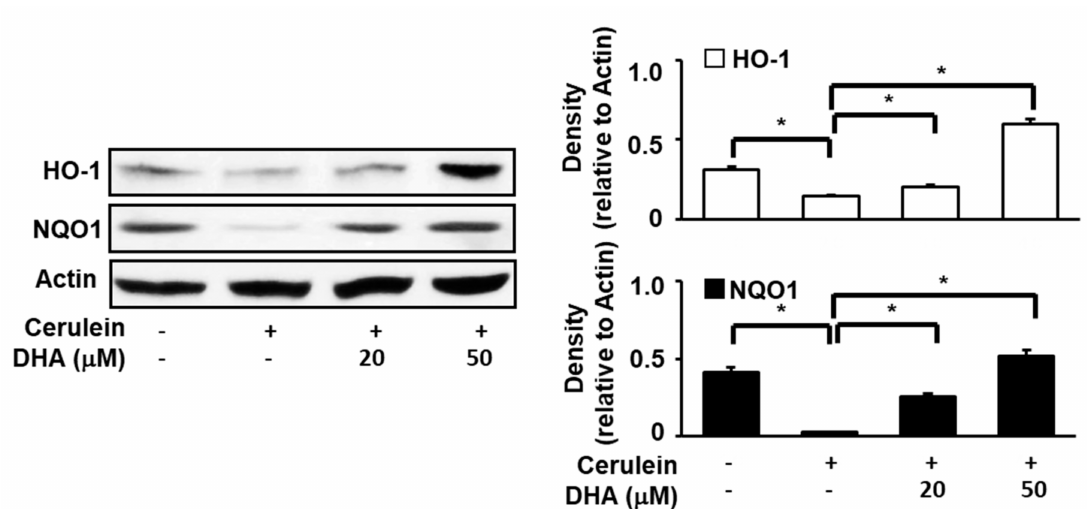
Figure 3. E ff ect of DHA on the expression of HO-1 and NQO1 in cerulein-stimulated AR42J cells. Cells (8 × 10 5 / dish) were pretreated with DHA (20 or 50 µ M) for 1 h and subsequently stimulated with cerulein (10 − 8 M) for 1 h. Protein levels of HO-1 and NQO1 in whole-cell extracts were determined by Western blot analysis, using actin as the loading control. The densitometry data represent means ± S.E. from three immunoblots and are shown as relative density of protein band normalized to actin level. * p < 0.05. + , with treatment; − , without